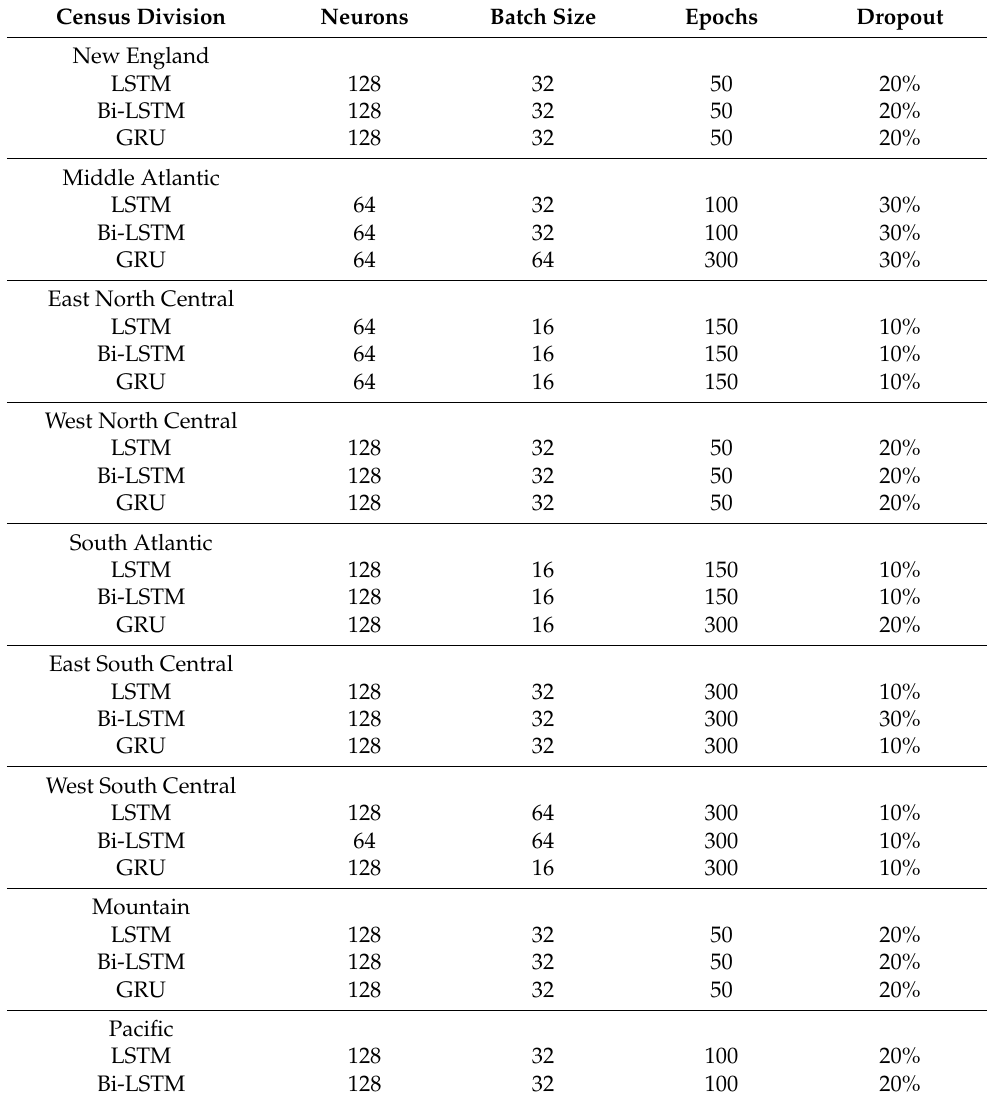
Table 5. The number of neurons, batch size, epochs, and dropout percent for the female database by